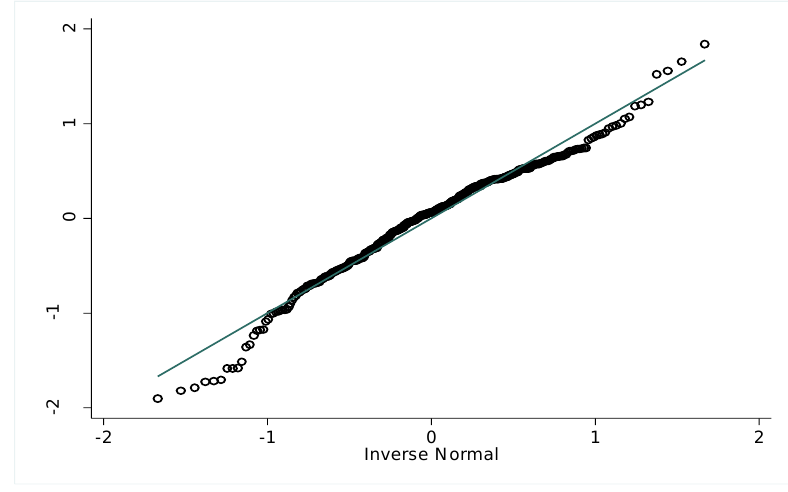
Figure 2: Q-Q plot for level-1 residuals; Assurance Customer satisfaction model Hanging rootograms with confidence intervals (CI) were also generated to assess and confirm whether the residuals were deviating from normality or not (Figure 3). Some of the hanging roots of the level-1 residuals have confidence intervals within the zero mean. However, 5 of the hanging roots show residuals that are significantly greater or less than zero based on the 95% confidence intervals below or above zero. This shows that the level-1 residuals for this model significantly violated the normality assumption.